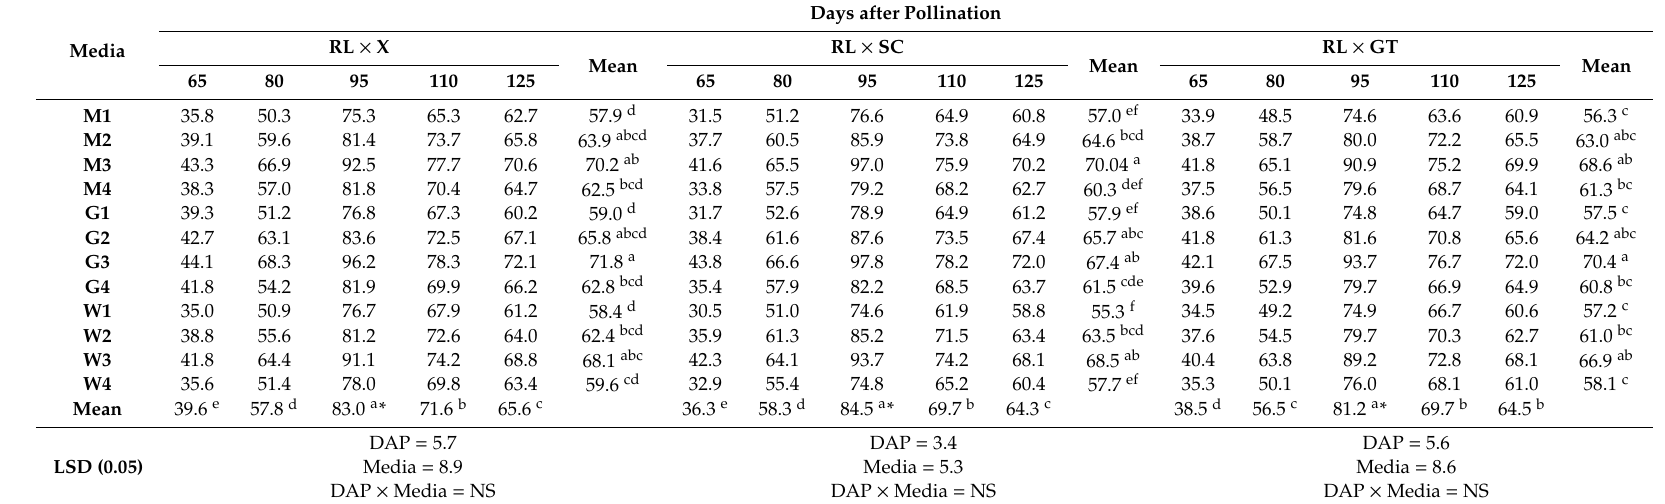
Table 3. E ff ect of rescue stage and medium on the germination of F 1 embryos from three crosses.